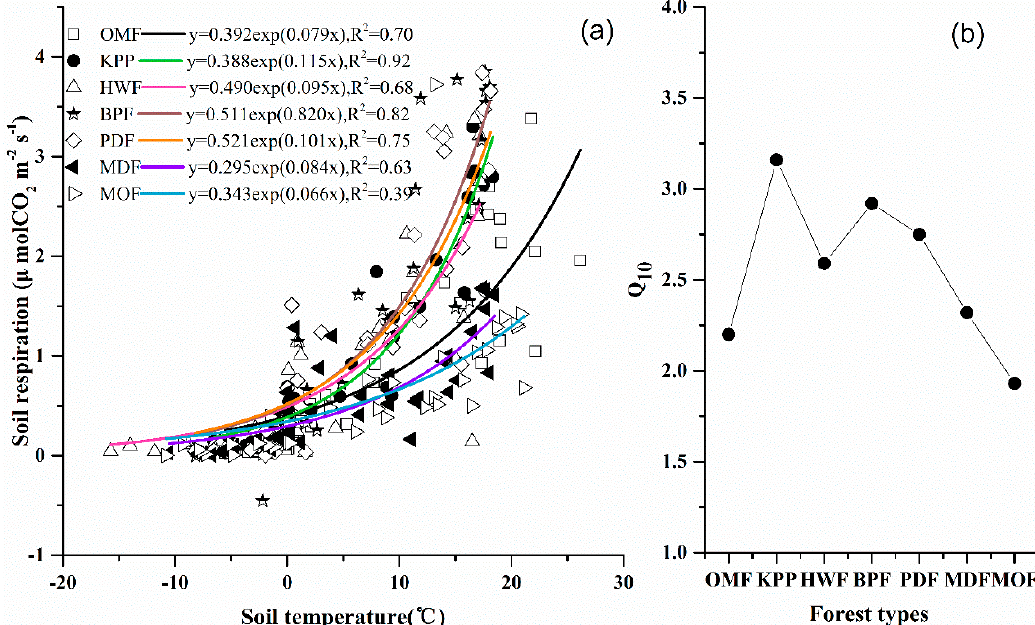
Figure 4. Relationships between soil respiration and soil temperature at a depth of 5 cm ( a ) and Q 10 ( b ) for the seven forest stands.